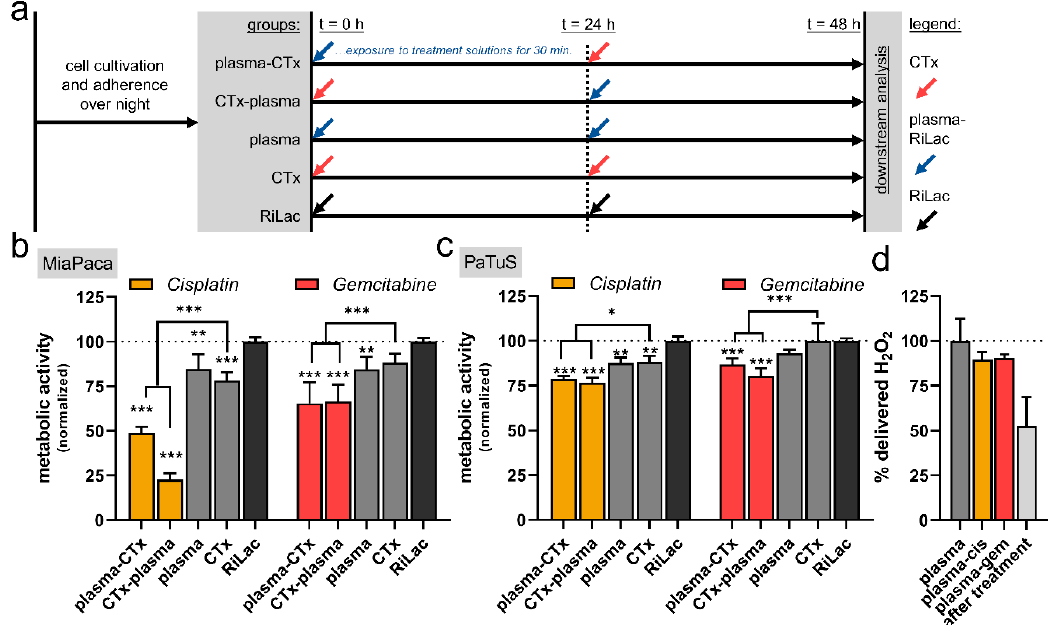
Figure 2. Additive decrease of metabolic activity using cisplatin or gemcitabine with physical plasma-conditioned Ringer’s lactate in pancreatic cancer cells. ( a ) Experimental procedure of the in vitro treatment regimens with the application of different treatment liquids (30 min exposure time; CTx = chemotherapeutic agents, plasma = physical-plasma-conditioned Ringer’s lactate, RiLac = Ringer’s lactate before the solutions were replaced with fresh cell culture medium) at 0 h and 24 h, as well as downstream analysis at 48 h; ( b , c ) the metabolic activity at 48 h of ( b ) MiaPaca and ( c ) PaTuS pancreatic cancer cells; ( d ) percent of the amount of H 2 O 2 initially induced through the plasma treatment in the combinational regimen and post-exposure to plasma-conditioned RiLac. Data ( b , c ) are representatives out of eight independent experiments, or ( d ) representatives showing mean + SD. Statistical significance was calculated utilizing ANOVA.